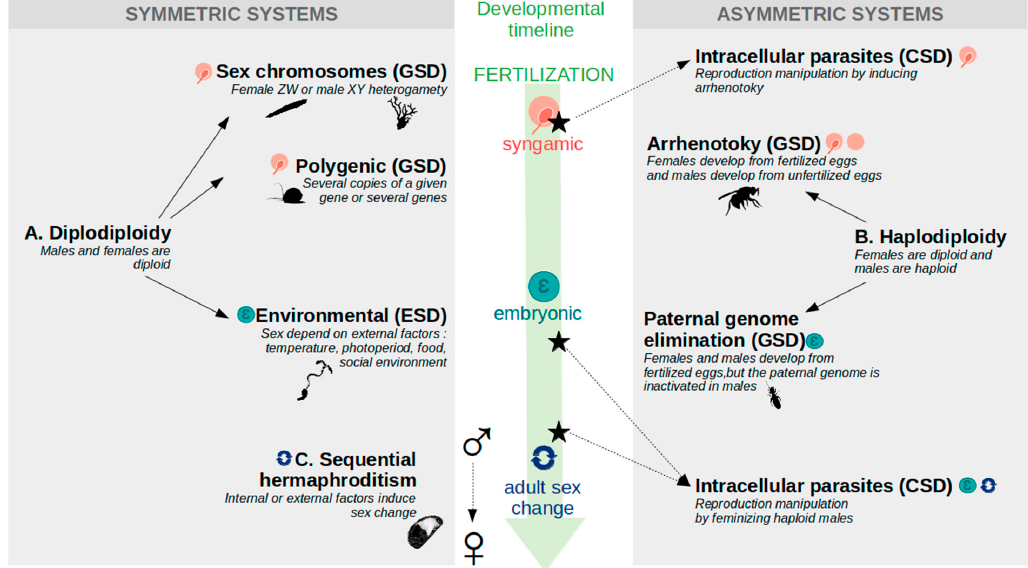
Figure 3. Timeline of invertebrate sex determination systems. Sex determination systems can be divided between symmetric (left panel) and asymmetric (right panel) systems, respectively, characterized by an equal participation of the father and the mother genome in the offspring, or by a different genetic role for both parents (here to the benefit of the mother). ( A ): diplodiploid systems, with both sexes carrying a maternal and a paternal genome sets, include: (1) genetic sex determination systems (GSD), where the sex fate is defined at the time of fertilization («syngamic») and which rely on (i) sex chromosomes such as the ZW of Branchiostoma floridae , or XY pair of Corallium rubrum , or (ii) multilocus sex determination like in Pomacea canaliculata ; (2) environmental sex determination systems (ESD), where the sex fate is acquired during the embryonic life such as in Bonellia viridis . ( B ): haplodiploidy is a GSD characterized by diploid females and haploid males, the latter being produced either by arrhenotoky such as in Nasonia vitripennis , or by embryonic paternal genome elimination like in Liposcelis booklice. Intracellular parasites can manipulate the sex of haplodiploid species (cytoplasmic sex determination, CSD), either by inducing the arrhenotoky at the time of the zygote production, or by feminizing haploid males later in life. ( C ): sequential hermaphroditism, or sex change at the adult stage like in Crepidula fornicata , can rely on internal or environmental factors (or a conjugation of both).